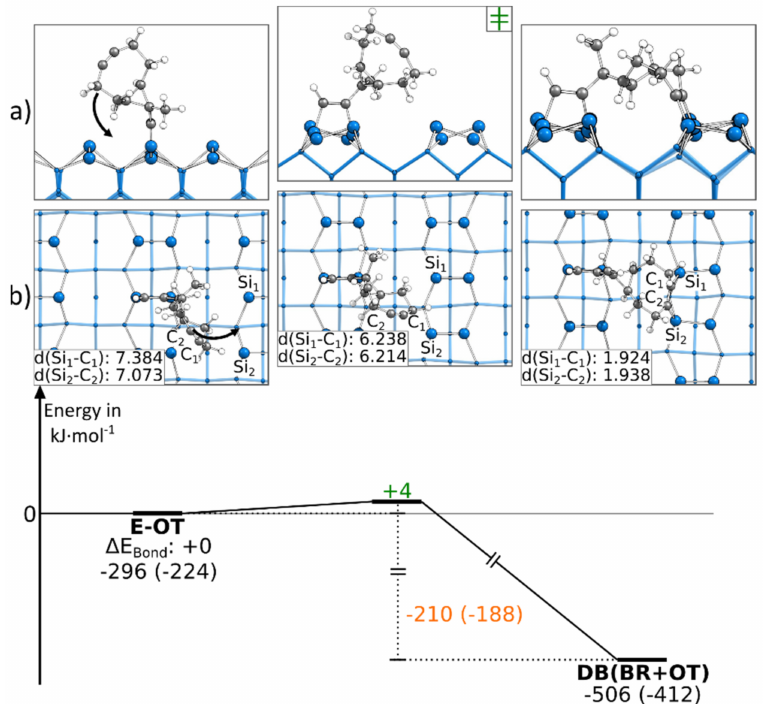
Figure 6. Reaction from an E-OT to a DB(BR+OT) structure, with side ( a ) and top ( b ) views of the minima and transition states. Electronic (Gibbs) bonding energies are stated for the minima. Activation energies ( ∆ E Act ) are shown in green, and electronic (Gibbs) reaction energies ( ∆ E React ) are shown in orange. All values are expressed in kJ · mol − 1 , and Si-C bond lengths are expressed in